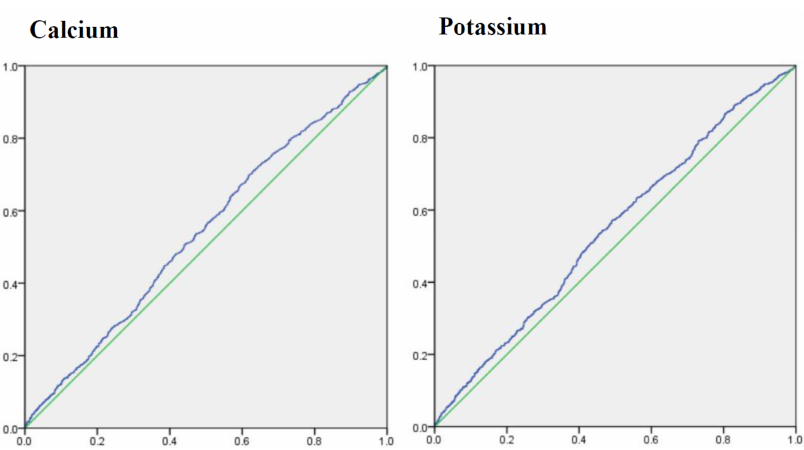
Figure 3. Areas under receiver operating characteristic curve for calcium and potassium.